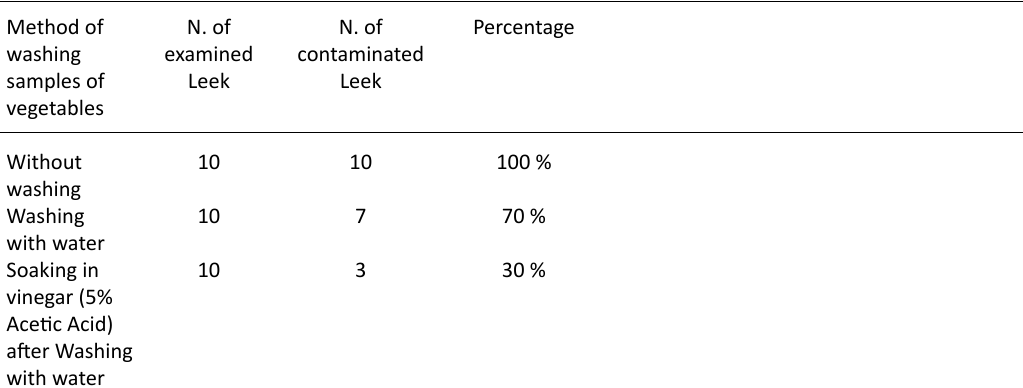
Acetic Acid) after Washing with